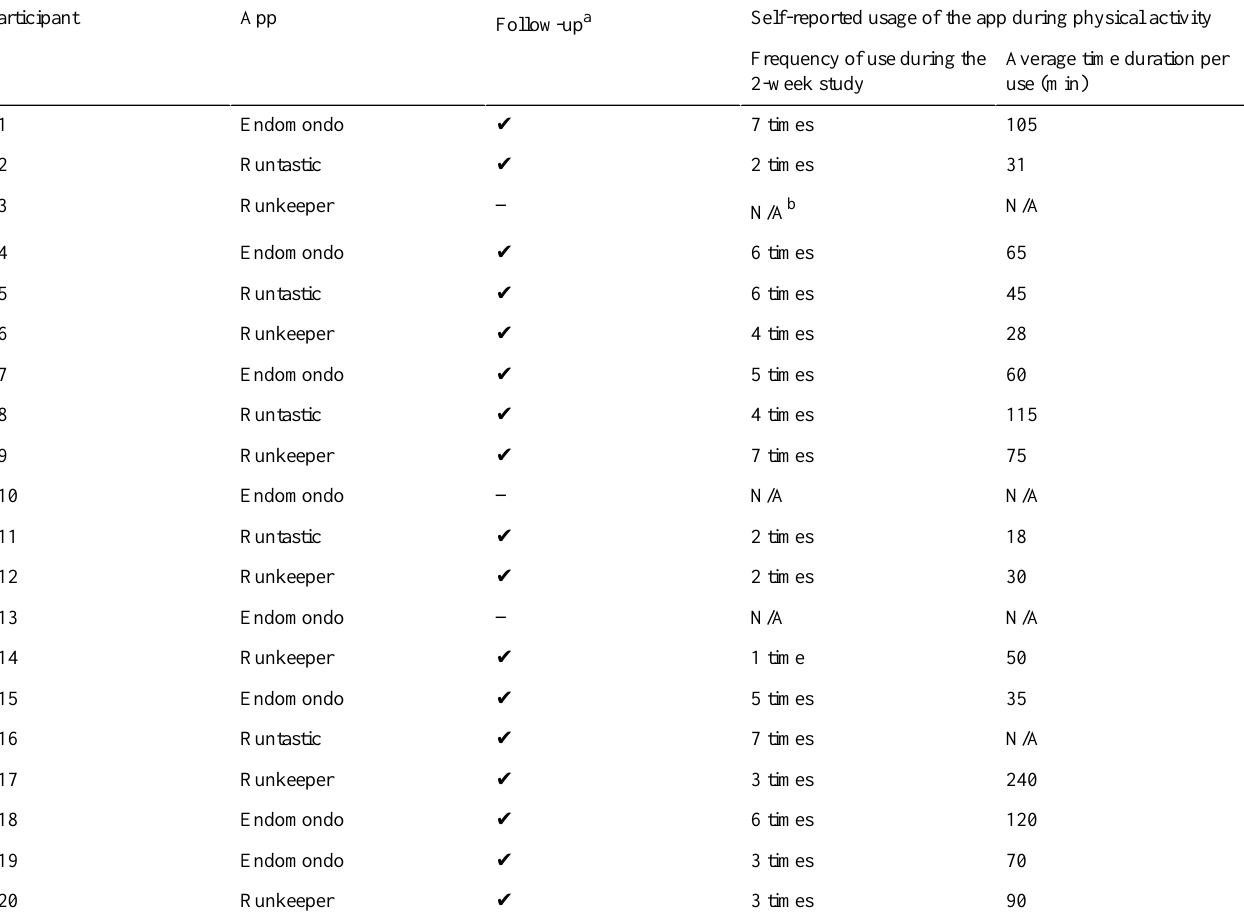
Table 2. Information about app allocation to participants, presence at follow-up and self-reported usage of the app during physical activity session. Average use during the 2-week study was 4.3 times and average time duration per use was 73.6